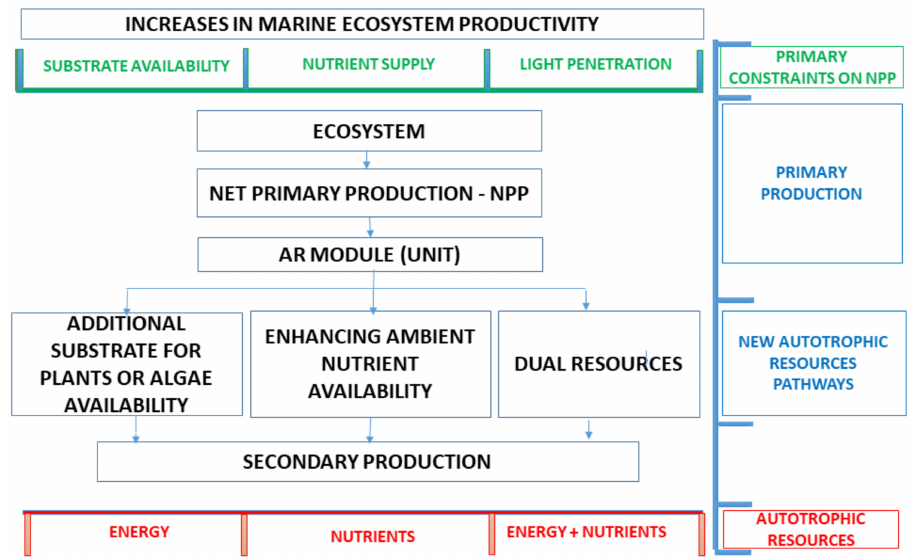
Figure 2. The MEEM model and its impacts on a specific ecosystem in terms of energy and nutrient availability. Black: flowchart, green: primary constraints on NPP, blue: trophic levels, red: autotrophic resource